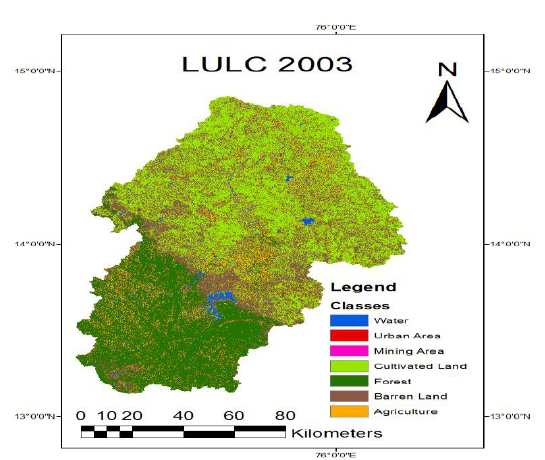
Figure 5 Land use land cover map of 1993